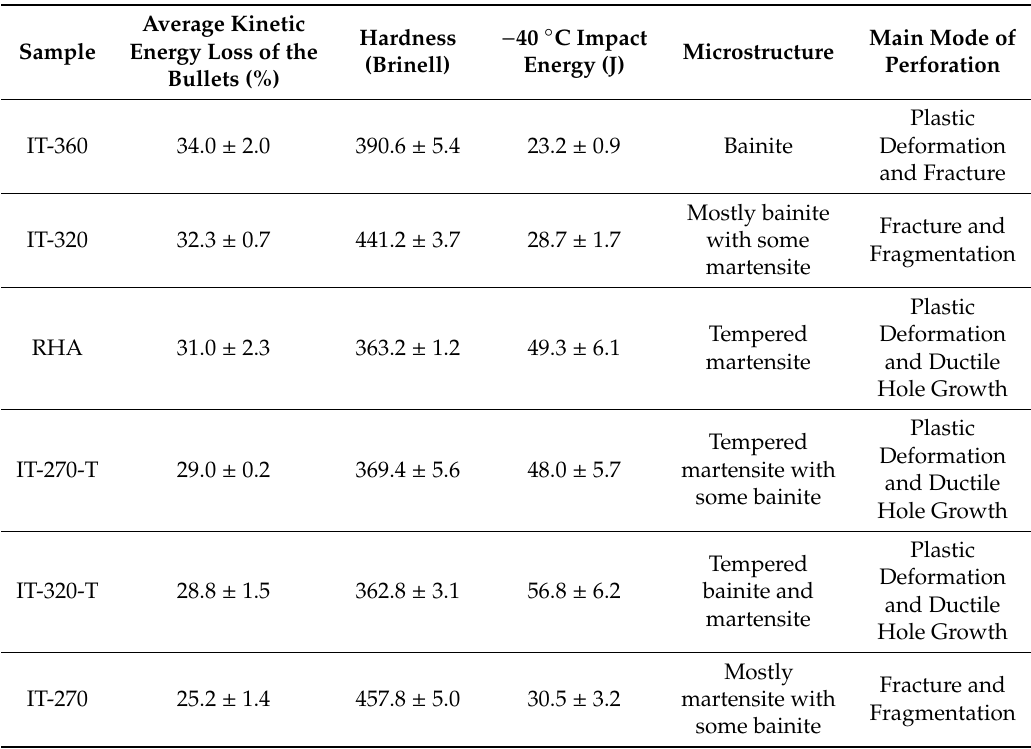
Table 5. Hardness and impact energies of the samples listed in the order of their decreasing ballistic protection